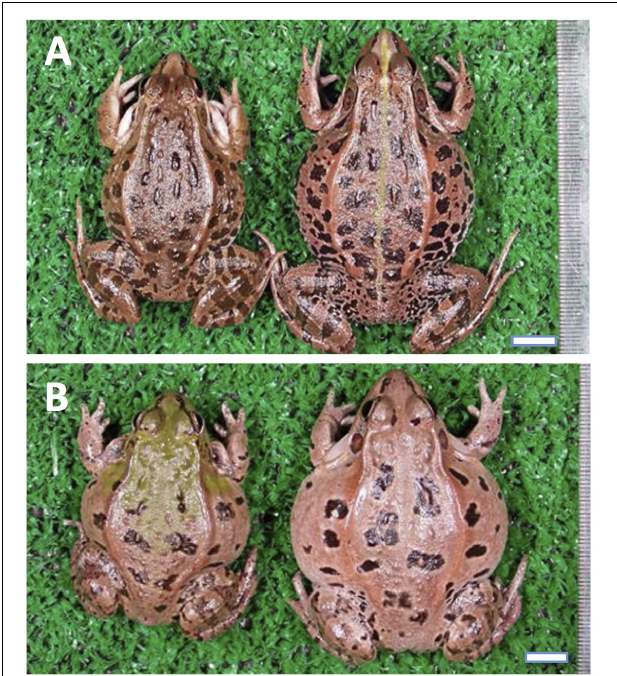
FIGURE 2 | The collecting localities of Pelophylax porosus brevipodus. Populations 5 to 12, which are placed under a hatched bar (150 km) with a question mark, have never been examined genetically since the primary morphological study of Moriya (1954). References 1–5: Nishioka et al. (1992), Sumida et al. (1998, 2000a,b), Komaki et al. (2015). See the localities (shown in number) in Table 1 . Hi, Hiroshima prefecture; O, Okayama prefecture; Hyogo, Hyogo prefecture; M, Mie prefecture; G/A, Gifu and Aichi